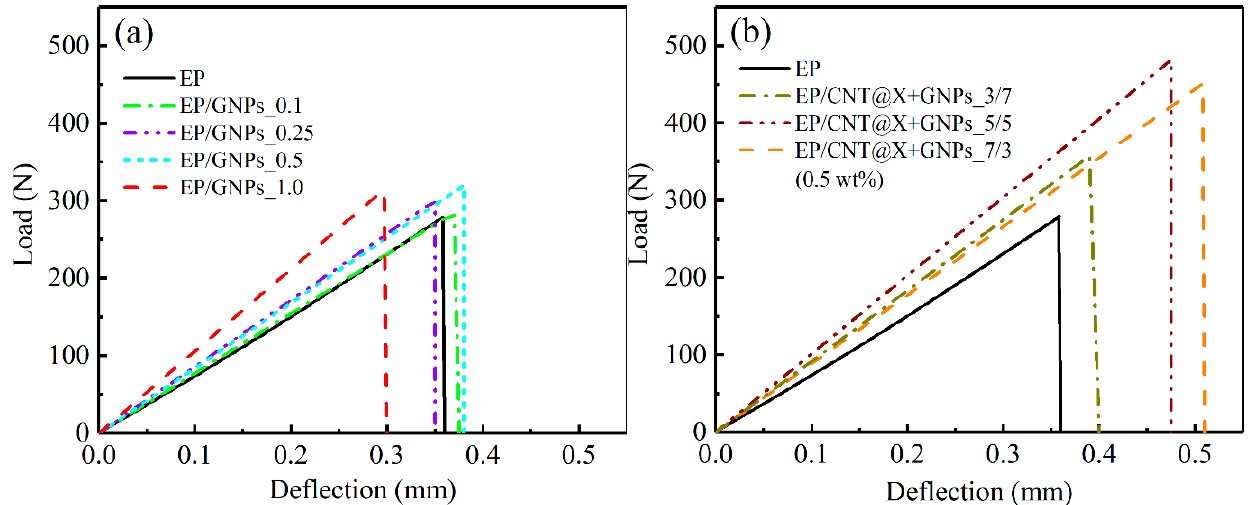
Figure 6. Load-deflection curves of the ( a ) EP/GNPs and ( b ) EP/CNT@X+GNPs nanocomposite specimens under the quasi-static 3P-ENB loading condition. Table 4. Quasi-static mechanical properties of the EP/GNPs and EP/CNT@X+GNPs nanocomposite specimens.